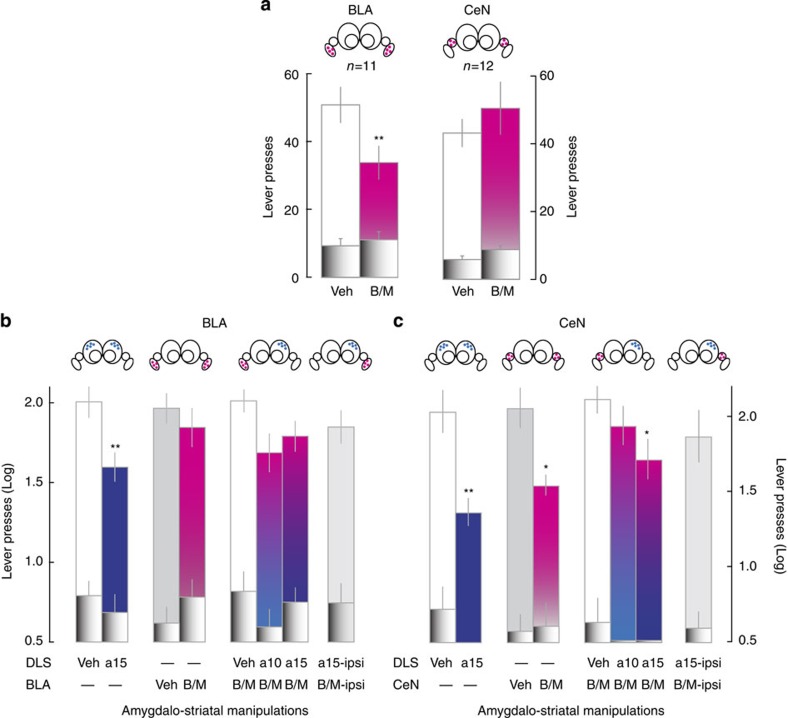
Basolateral to central amygdala shift in the control over aDLS dopamine-dependent cocaine seeking habits.(a) Active lever presses during early stages cocaine seeking were decreased by B/M infusions into the BLA, but not the CeN (main effect of lever: F1,21=138.55, P<0.001, partial η2=0.86; dose × structure interaction: F1,21=7.54, P<0.013, partial η2=0.26 and dose × lever × structure interaction: F1,21=7.01, P<0.015, partial η2=0.25). When cocaine-seeking behaviour was well-established, bilateral infusions of α-flupenthixol (a) into the aDLS decreased active lever presses both in the BLA (b) and CeN (c) groups (main effect of lever: F1,21=173.82, P<0.001, partial η2=0.89; dose: F1,21=34.19, P<0.001, partial η2=0.61; dose × lever interaction: F1,21=9.07, P<0.01, partial η2=0.30 but no dose × lever × structure interaction: F1,21<1). However, active lever presses were decreased both by bilateral inactivation of the CeN and functional disconnection of the CeN and aDLS (main effect of lever: F1,10=148.49, P<0.001, partial η2=0.93; manipulation: F4,40=3.32, P<0.02, partial η2=0.25 and lever × manipulation interaction: F4,40=3.045, P<0.05, partial η2=0.23) to the same extent as by bilateral aDLS α-flupenthixol infusions (Fs1,10<1) (c). In marked contrast, bilateral inactivation of the BLA or functional disconnections of the BLA and the aDLS had no influence on active lever presses when cocaine seeking was established as a habit (main effect of lever: F1,11=357.80, P<0.001, partial η2=0.97; manipulation: F4,44=1.17, P>0.16, partial η2=0.13 and lever × manipulation interaction: F4,44=1.67, P>17, partial η2=0.13). *: different from vehicle, P<0.05; **: different from vehicle, P<0.01, Newman–Keuls post hoc test. Pink fills represent intra-amygdala B/M infusion. Blue fills represent intra-aDLS infusions of α-flupenthixol. B/M, baclofen/muscimol mixture. Inactive lever presses are represented by black shaded fills.